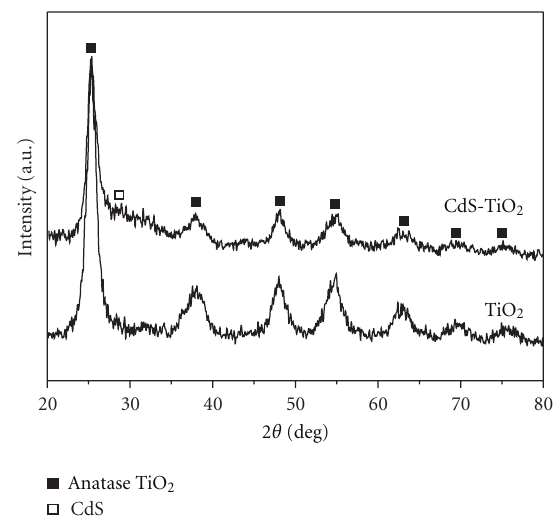
Figure 1: XRD patterns of CdS-TiO 2 and TiO 2 samples.